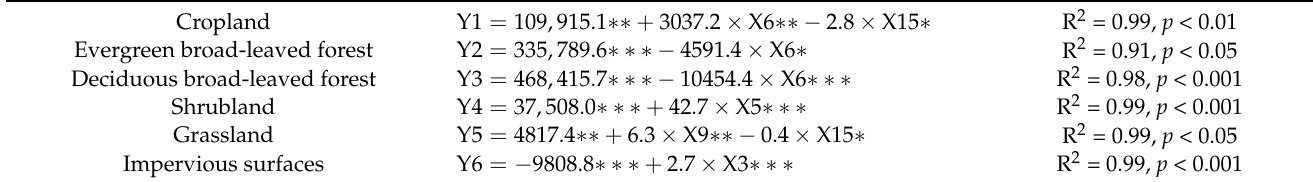
Table 6. Results of multiple stepwise regression analysis of the area and driving factors for different LUC